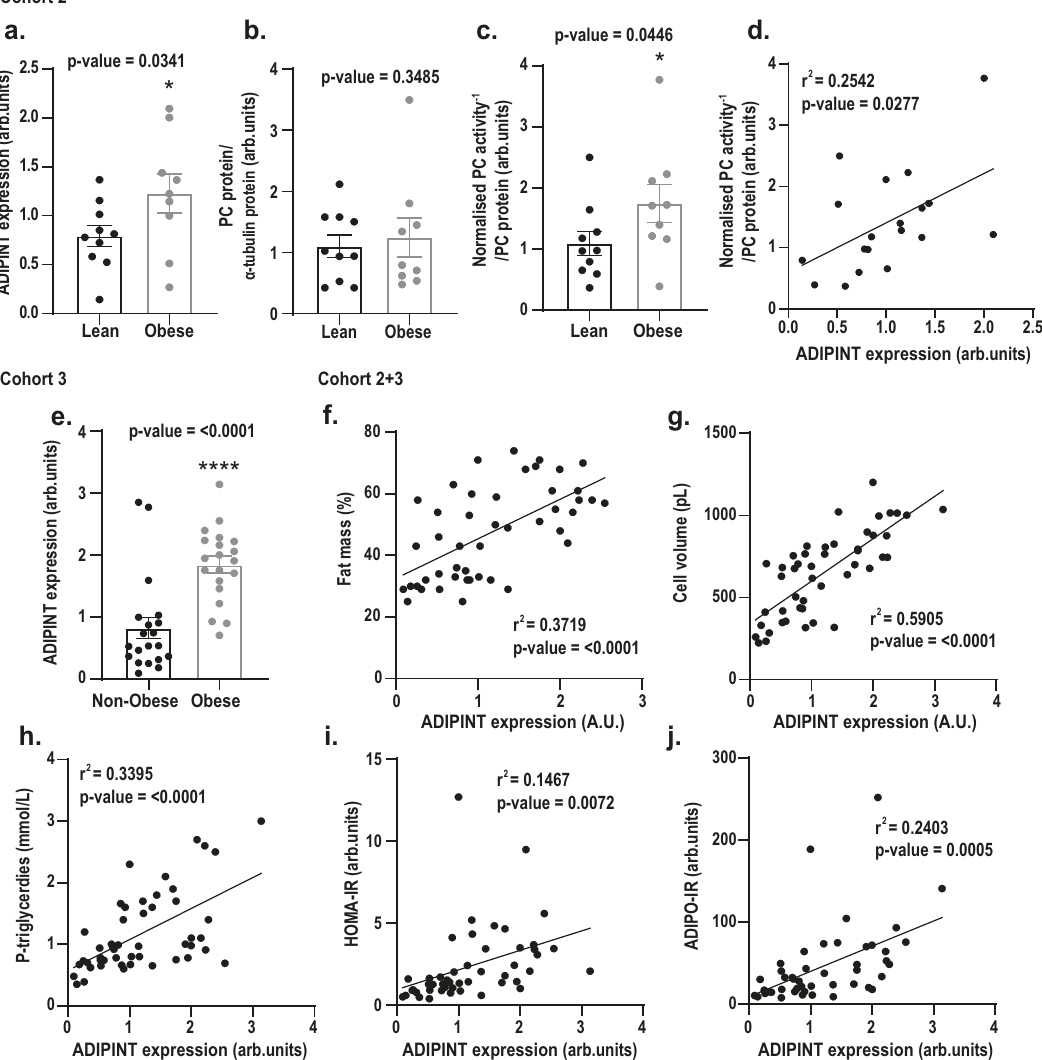
Fig. 6 Subcutaneous adipose ADIPINT expression and PC activity correlate with each other and are increased in obesity. Analyses of a ADIPINT expression, b PC protein and c PC activity in subcutaneous adipose tissue of 10 women without obesity (lean) and 9 women with obesity (Cohort 2). d ADIPINT expression plotted against PC activity in the same patient. A body mass index (BMI) of ≥ 30 kg/m 2 was used to distinguish individuals with obesity and BMI of <25 kg/m 2 for control. PC activity was normalized to PC protein expression from the same adipose tissue sample. e ADIPINT expression in subcutaneous adipose tissue of 20 women without obesity and 20 women with obesity (Cohort 3). A BMI of ≥ 30 kg/m 2 was used to distinguish individuals with obesity and BMI of <30 kg/m 2 for control. ADIPINT expression from both Cohort 2 and 3 plotted against f total percentage fat mass, g fat cell volume, h plasma triglycerdies i homeostasis model assessment of insulin resistance (HOMA-IR) and adipose tissue insulin resistance index (ADIPO-IR). Linear regression assessed signi fi cance in correlation analyses. A one-tailed t -test assessed signi fi cance between individuals with and without obesity. Each data point represents an individual patient, error bars represent SEM. Source data are provided as a Source Data fi Fluorescence microscopy . RNA-FISH assays for ADIPINT using the View- RNA ® ISH Cell Plus Assay Kit (Affymetrix) according to the manufacturer ’ s instructions. Type 6 probes against ADIPINT were ordered from the same supplier. Brie fl y, hADSC were cultured in Millicell EZ SLIDE 4-well glass chambers (Merck Chemicals and Life Science AB). At day 13 of differentiation, the adipocytes were washed with phosphate buffered saline (PBS) and fi xed in 4% paraformaldehyde for 20 min at room temperature. Subsequently, probes were hybridized for 2 h at 40 °C. After hybridization and ampli fi cation steps with pre-ampli fi er, ampli fi er, and linked labelled probe, the probes were detected using Alexa ® Fluor 650 dyes, according to the manufacturer ’ s instructions. Cells were stained with 1:2500 BODIPY 493/503 and Hoechst 33342 for 20 min before mounting with ProLong Gold Antifade Mountant (ThermoFisher). Images were obtained with a Nikon spinning disk confocal microscope system (Nikon) equipped with a Nikon ECLIPSE Ti inverted microscope and a 1.4 NA x60 oil immersion objective (Nikon), under the control of NIS-Elements AR version 4 software.